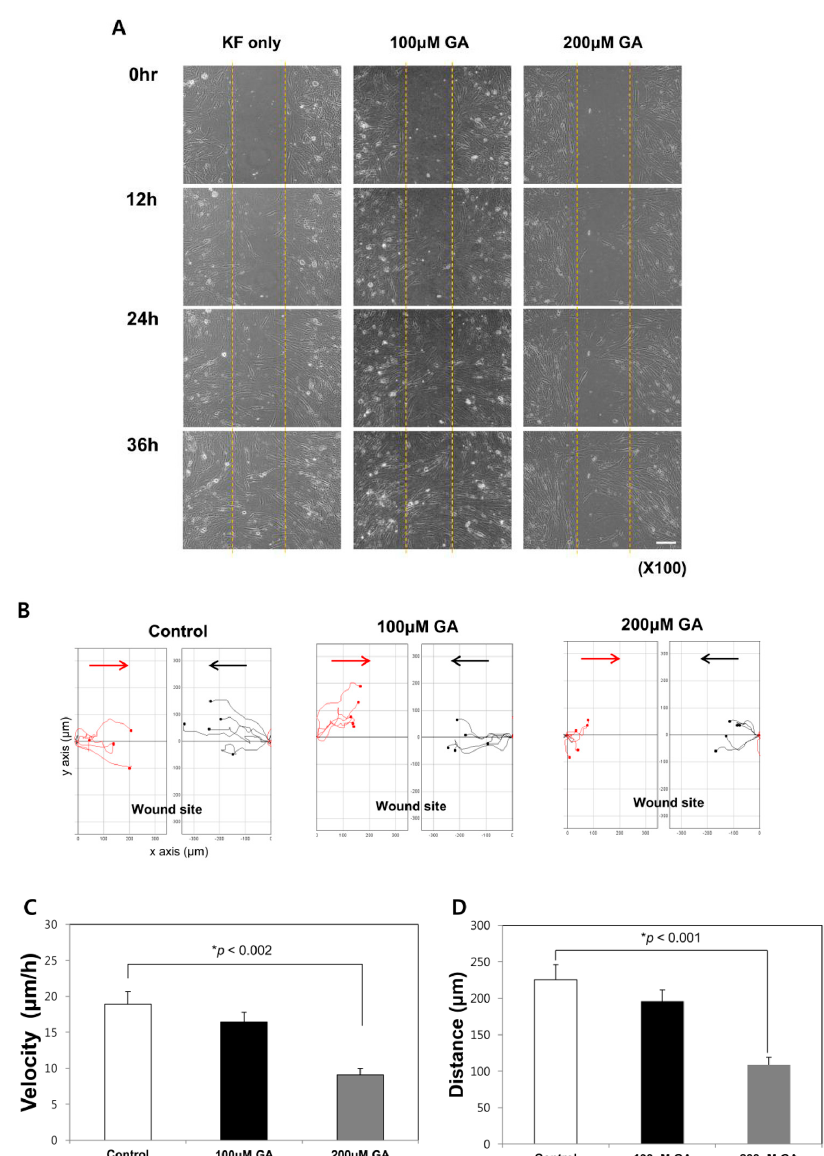
Figure 4. Glycyrrhizic acid (GA) inhibited keloid fibroblast activity. Scale bar: 50 μ m. ( A ) The in vitro wound healing assay showed decreased keloid fibroblast migration after GA treatment; ( B ) The cell tracking system for fibroblast migration was analyzed using cells selected from both sides of the wound, keloid fibroblasts were tracked toward the site of wound insert after cultivation for 24 h; black, cells toward the midline from the left edge; red, cells toward the midline from the right edge. GA-induced decreases in the average migration speed ( C ) and the average distance ( D ) traveled of keloid fibroblasts. All results are shown as mean ± SD (* p < 0.05).